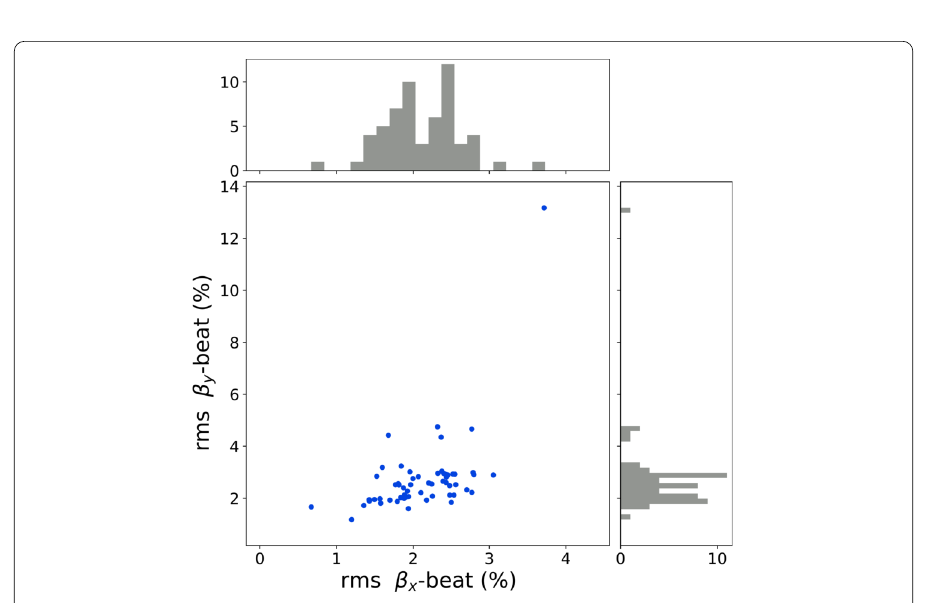
Figure 10 Beta-beating after correction for 100 lattices (i.e 100 random seeds) with the field errors in Table 3 and the misalignments in Table